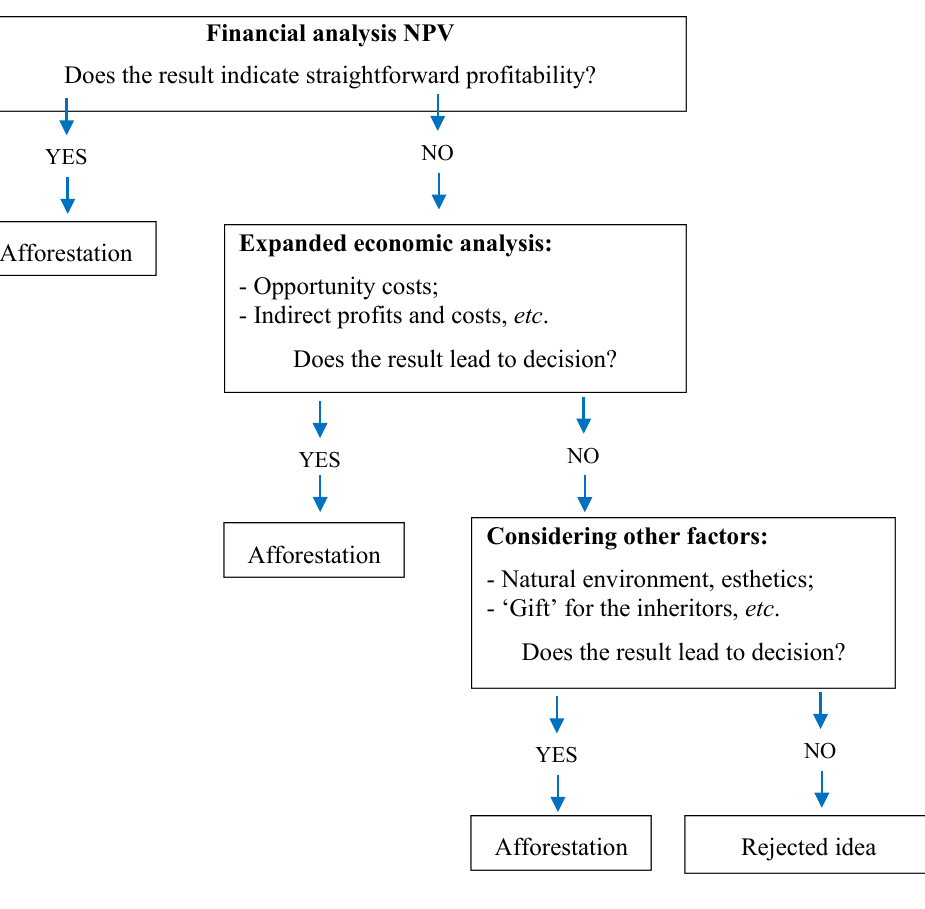
Figure 2. Algorithm for decision on